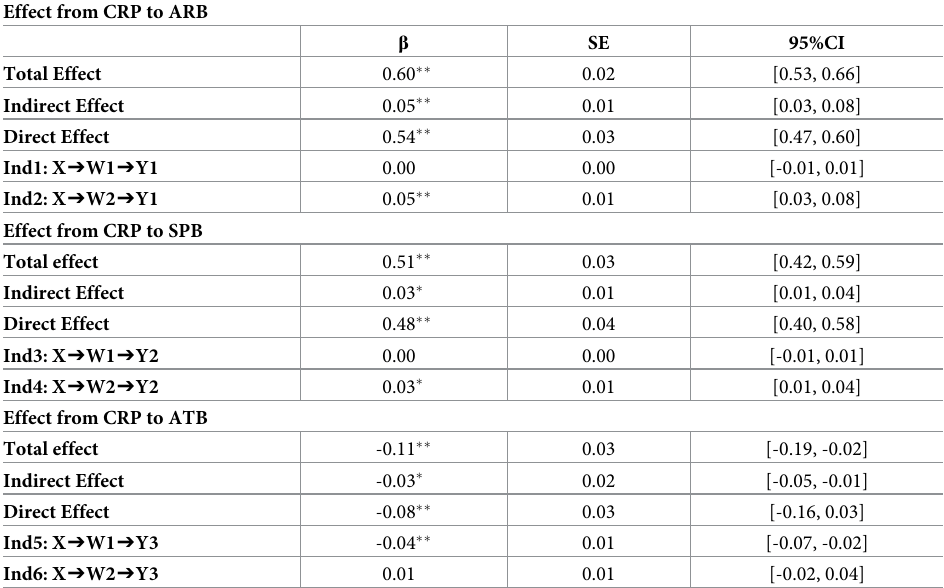
Table 3. Mediation model: Indirect effect between CRP and CRC through PE and NE. Effect from CRP to ARB